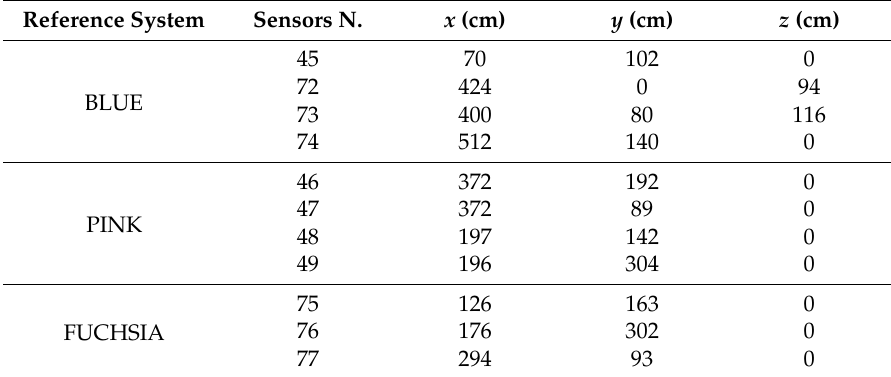
Figure 1. ( a ) Sensor locations (numbered triangles); ( b ) Sensor #85 (yellow triangle), outdoor climate control. Each sensor has a different color due to wall belonging. Each wall has a reference system ( xyz ) to individuate the sensor’s position (coordinate allocation is expressed in Table 1). Legend: pink color corresponds to wall A, fuchsia color corresponds to wall B, azure corresponds to wall C, blue color corresponds to wall D, yellow corresponds to wall E, red corresponds to wall F, green corresponds to wall G and violet corresponds to wall H. Table 1. Sensors description and coordinated allocation.